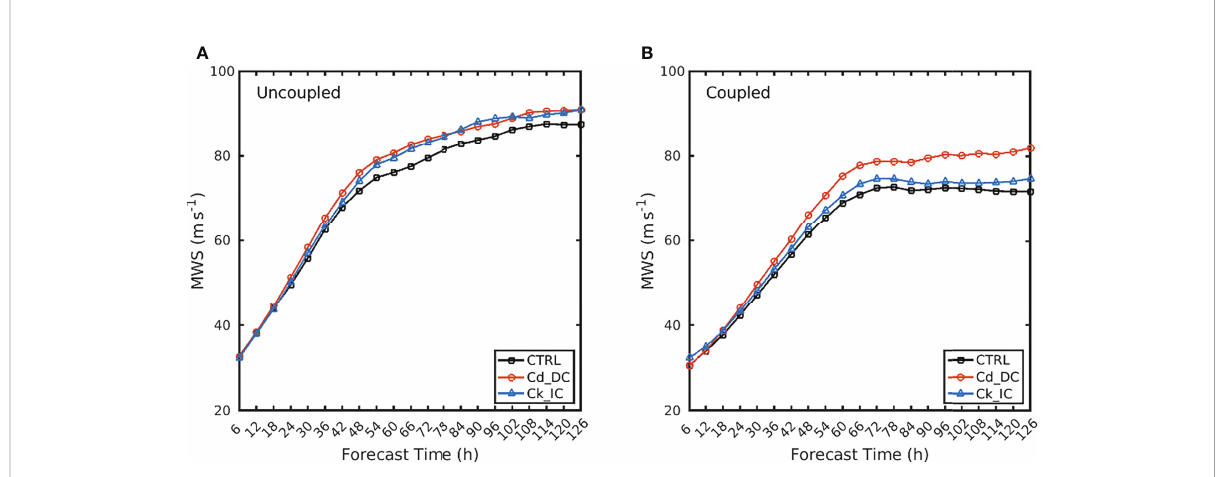
FIGURE 5 Time series of maximum wind speed (m s -1 ) for three simulations of idealized uncoupled (A) and coupled (B) experiments. Wind speeds are smoothed by a 48-h moving average.